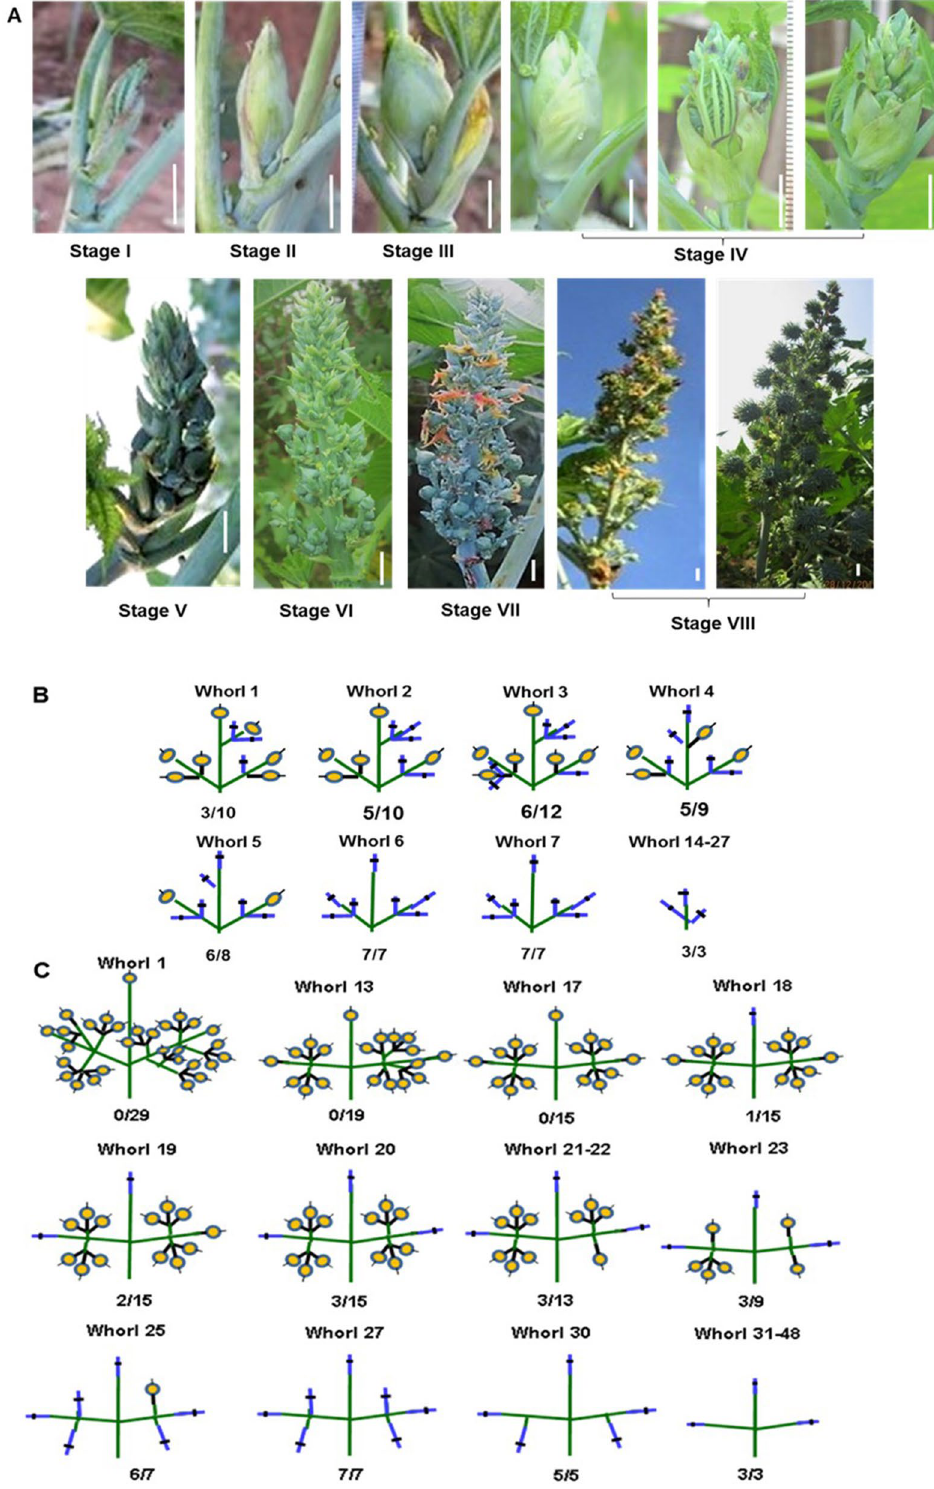
Figure 2. Morphological developmental stages and architecture of inflorescence. ( A ) Developmental stages of inflorescence (stage I-VIII) from primordia initiation to capsule setting. (DCS 107). ( B,C ) Inflorescence architecture in monoecious genotypes DCS 107 ( B ) and RG 156 ( C ). Floral whorl numbers counted from bottom of inflorescence and proportion of female flowers (fraction) in a whorl are shown. Quantitative information on inforescence growth, architecture and time for transtion to each stage are provided in Supplementary Figs. S2–S5 and Supplementary Tables S2 and